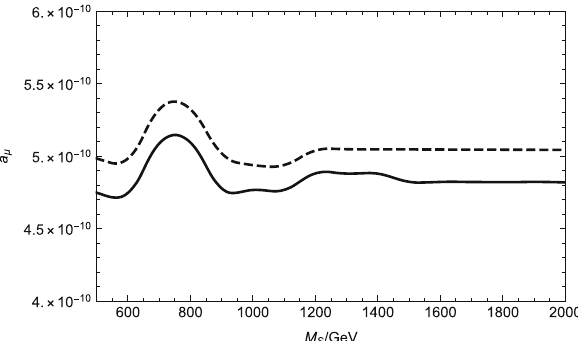
Fig. 5 a μ versus M S . The dashed (solid) line denotes the result with M 2 = 1200 ( 800 ) GeV